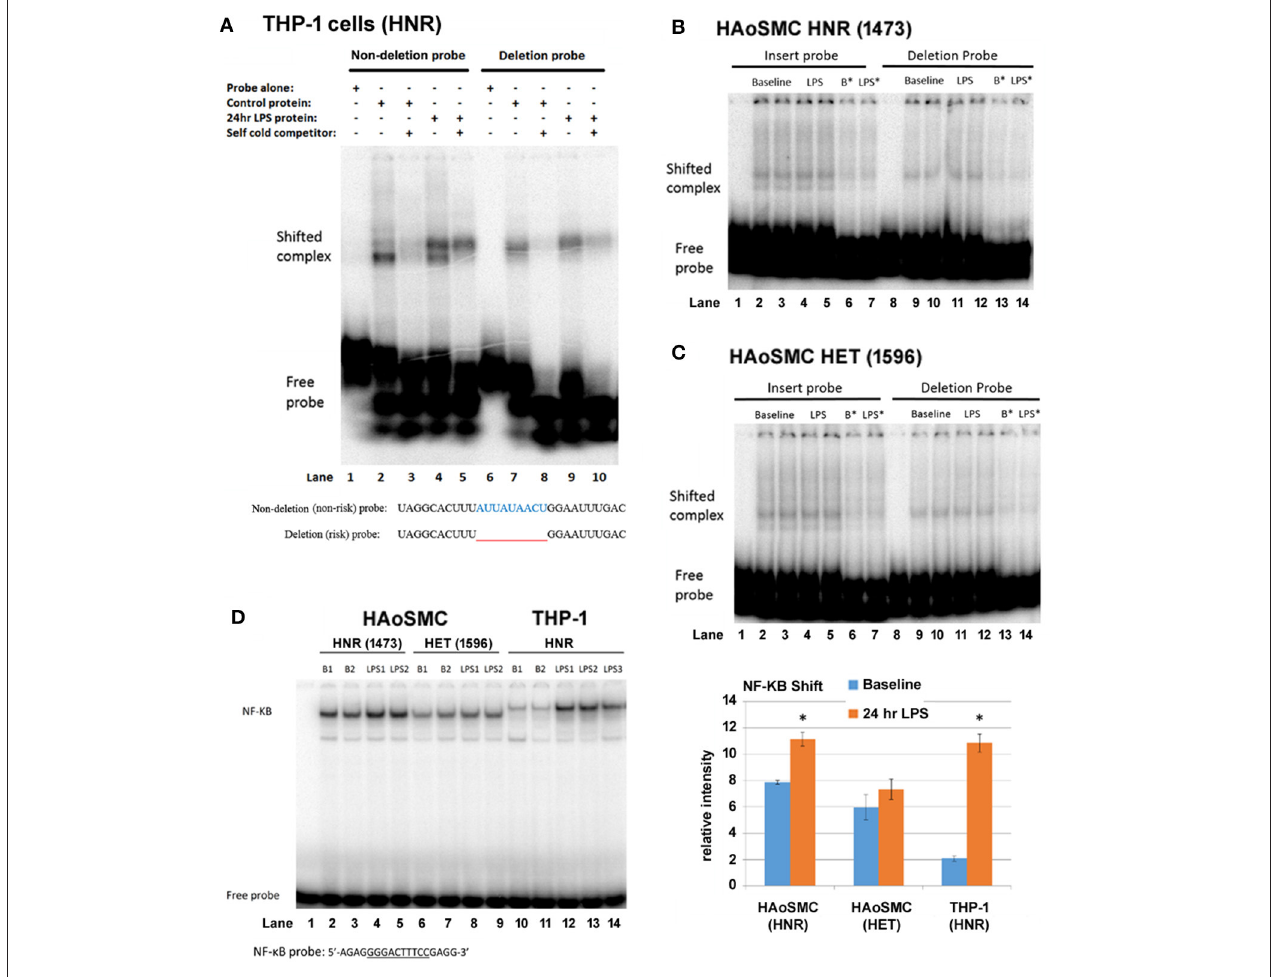
FIGURE 2 | THP-1 macrophages, but not HAoSMC, show differential complex formation between non-deletion (non-risk) and deleted (risk) probes after LPS treatment. (A) Representative RNA gel shifts of cytoplasmic RNA binding proteins from control or LPS-stimulated THP-1 macrophages. The sequence of the radiolabeled non-deletion (non-risk) and deleted (risk) single-stranded RNA probes is indicated below the autoradiograph. Lanes 1/6 are probes alone, lanes 2/7 are with control THP-1 extract, lanes 3 and 8 are with 1,000-fold cold probe competitor, lanes 4/9 are with LPS-treated THP-1 extract and lanes 5/10 are with the addition of cold competitor. LPS (100ng/ml). Note the appearance of a lower mobility (upper) shifted complex with LPS treatment only for the non-deletion (non-risk) probe. (B) Representative RNA gel shifts of cytoplasmic RNA binding proteins from control and LPS-treated HAoSMC from an HNR donor (1,473, top panel) and (C) a HET donor (1596, bottom panel). Non-deletion probe shows a doublet while the deleted probe shows a single shifted complex. LPS treatment has no visible effect on the intensity of shifted complexes. B* and LPS*, baseline or LPS + 1,000-fold cold competitor. (D) NF- κ B DNA gel shifts were used as a positive control for the LPS response. Nuclear proteins from HAoSMC from an HNR donor (1,473), from HAoSMC of a HET donor (1,596) and from THP-1 human macrophage cells were tested for binding to an NF- κ B specific double-stranded DNA probe (only the upper strand is shown). Phosphorimager quantitation of shifted complexes reveals a weak LPS response in HAoSMC compared to a robust LPS response in THP-1 macrophages. * p < 0.05 compared to own baseline by Student’s t